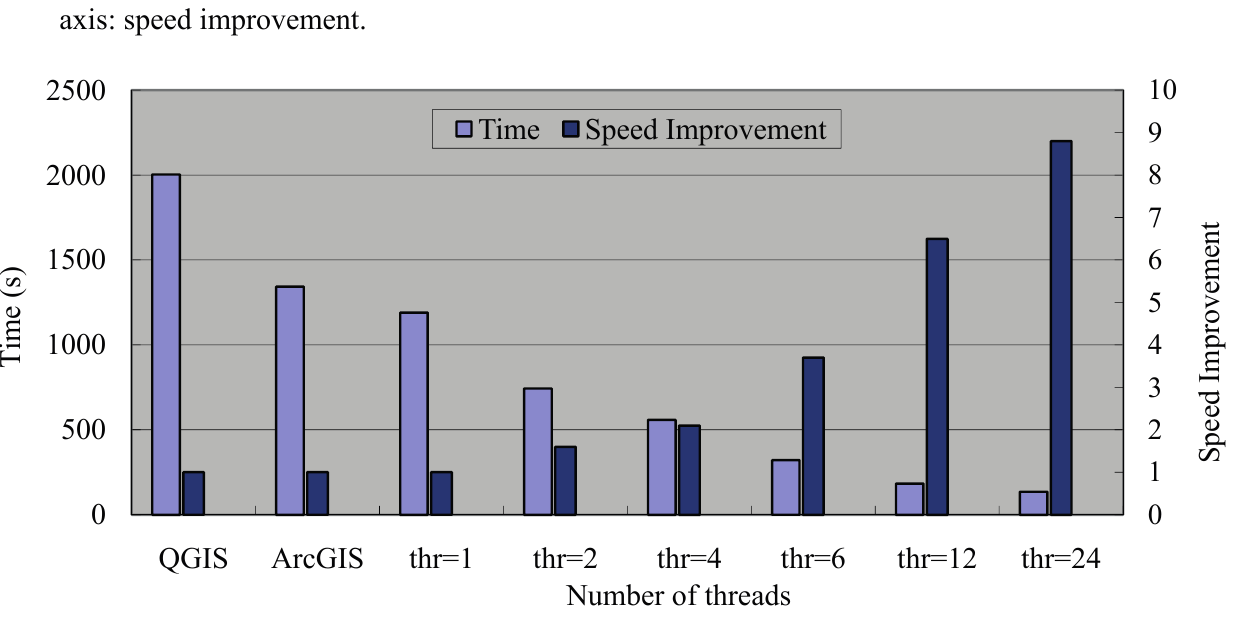
Figure 11. Efficiency of the intersection operation in ArcGIS, QGIS and SDDG-INTERSECT with different parallel computing threads. The left vertical axis: time; the right vertical axis: speed